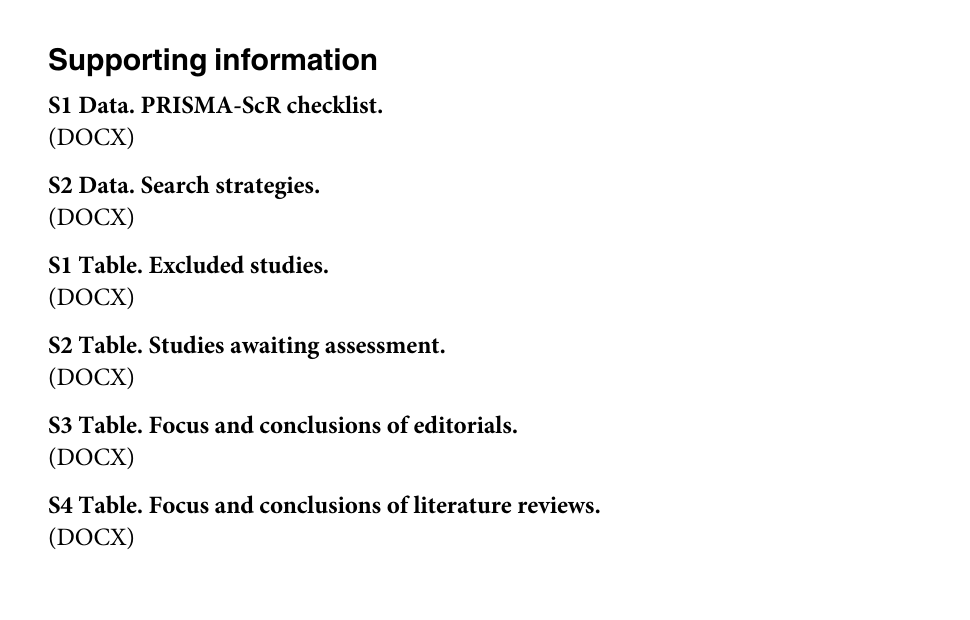
S1 Table. Excluded studies. S2 Table. Studies awaiting assessment. S3 Table. Focus and conclusions of editorials. S4 Table. Focus and conclusions of literature